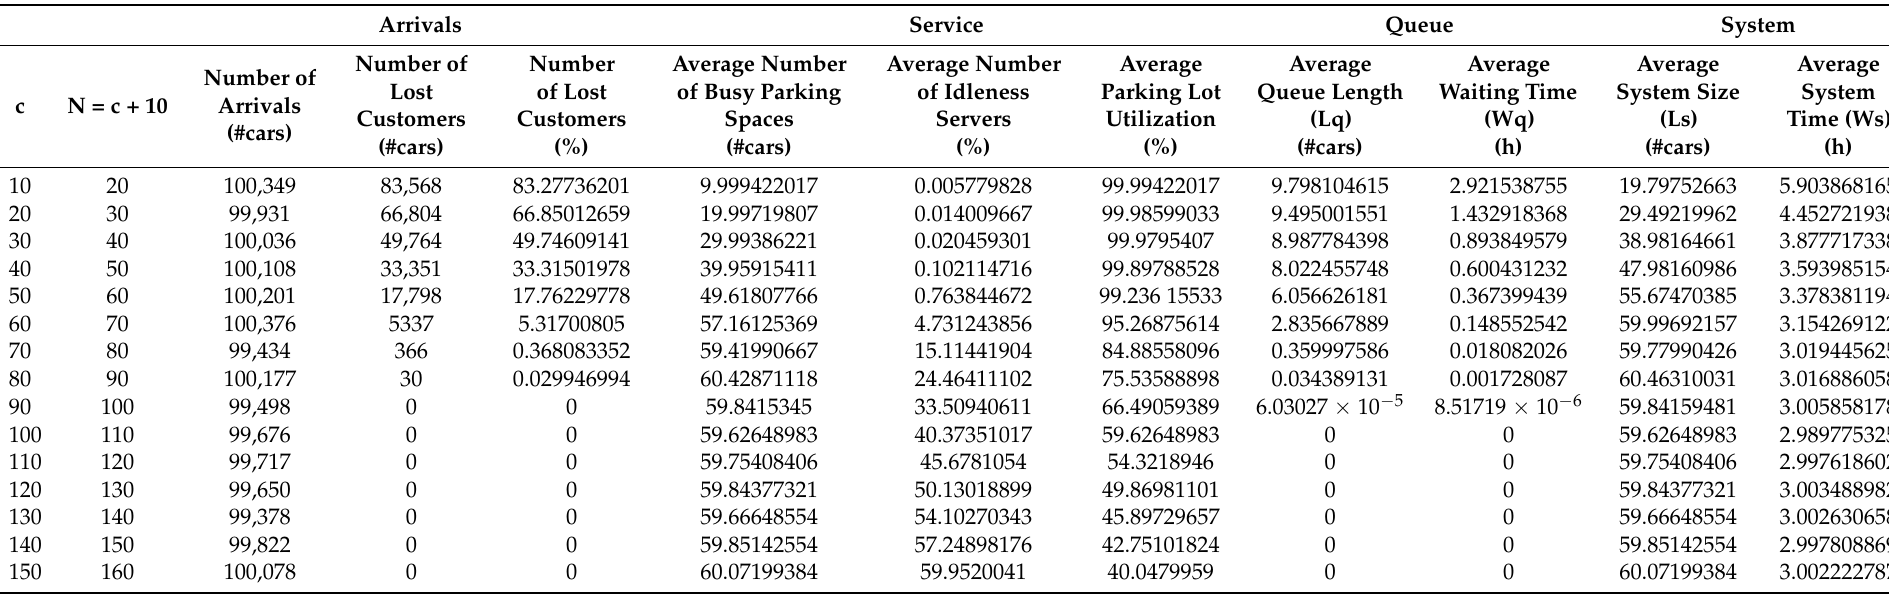
Table 13. Simulations of a parking lot model with an M/M/c/N queue subsystem for λ = 20 cars/h, µ = 0.333 cars/h, QC = 10 cars, and #parking spaces =